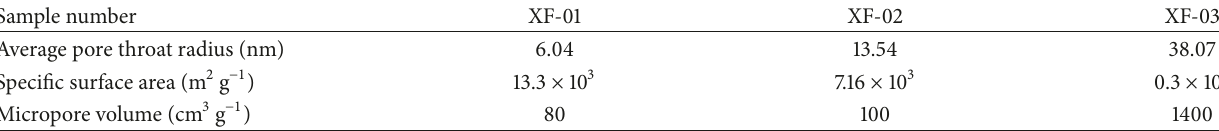
Table 3: The determined specific surface area and pore size using nitrogen absorption method.